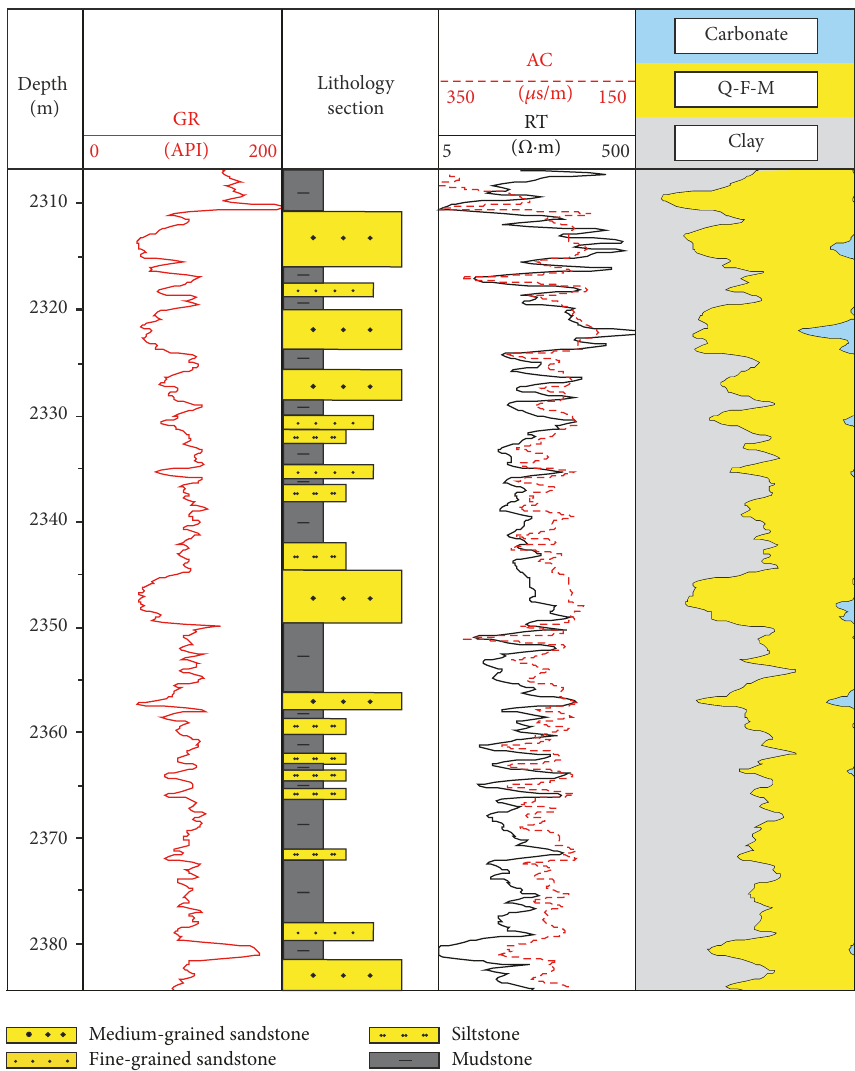
Figure 10: Diagenetic mineral assemblage characteristics interpreted by ECS logging in Well